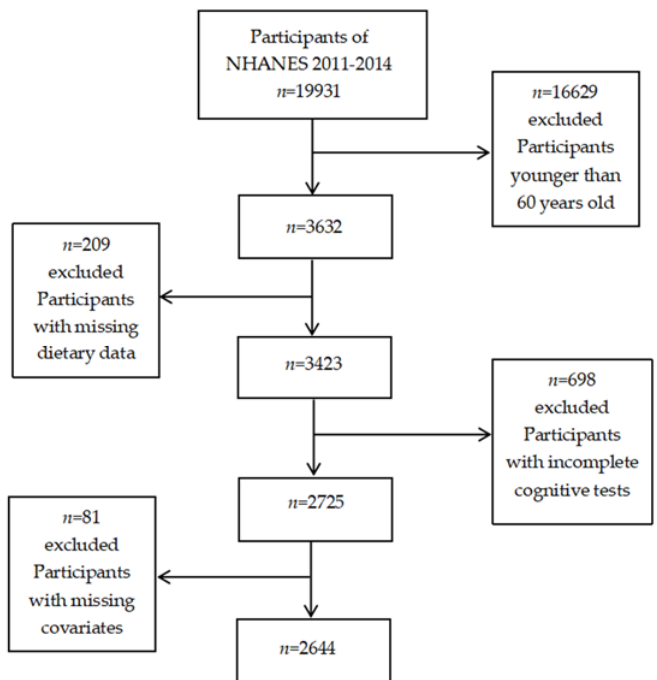
Figure 1. Flow chart for the selection of included sample.